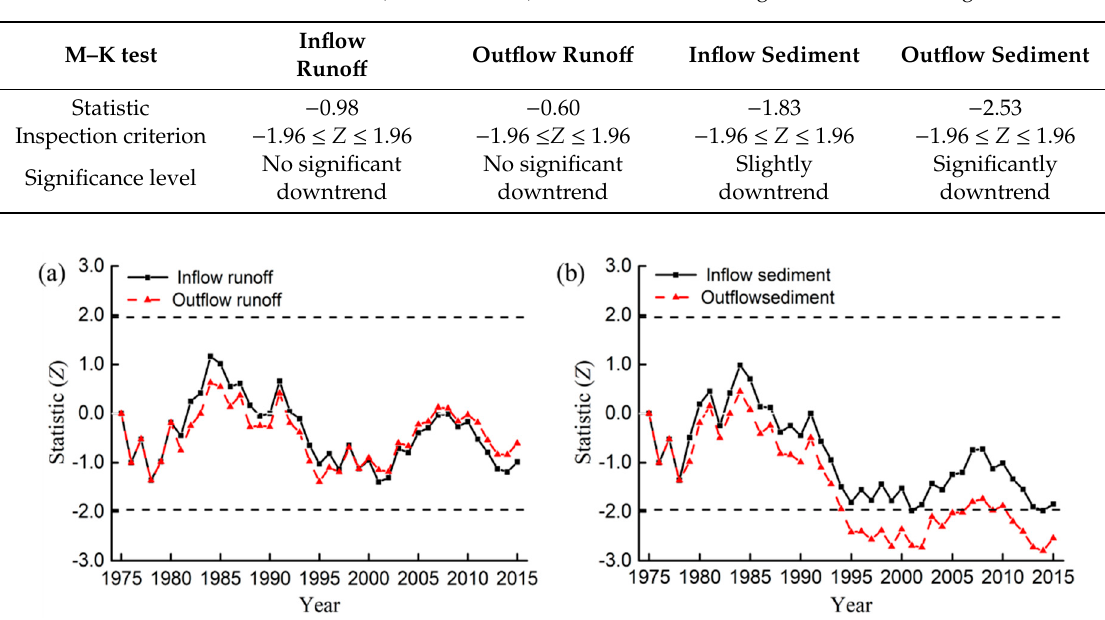
Figure 3. Results of M–K statistics series. ( a ) Runoff M–K statistics series; ( b ) Sediment M–K statistics series.